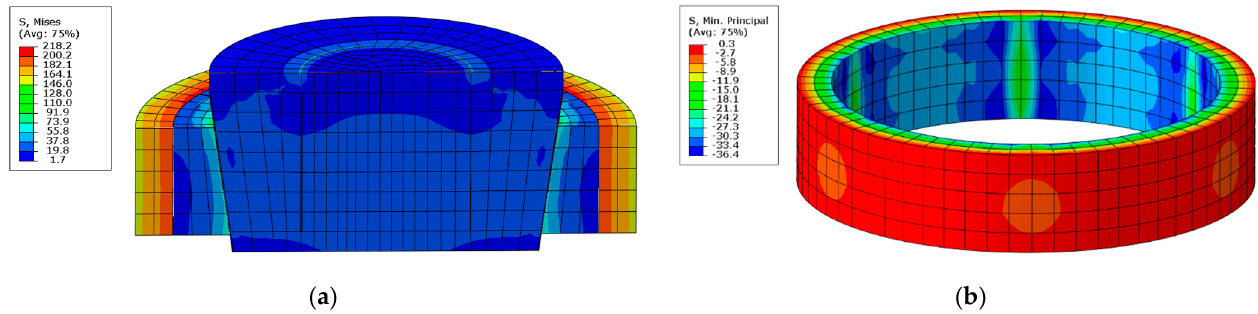
Figure 15. Results of the FEM analysis of the interaction of the split ring with the sample; reduced stresses ( a ), radial stresses: visible contact areas ( b ).